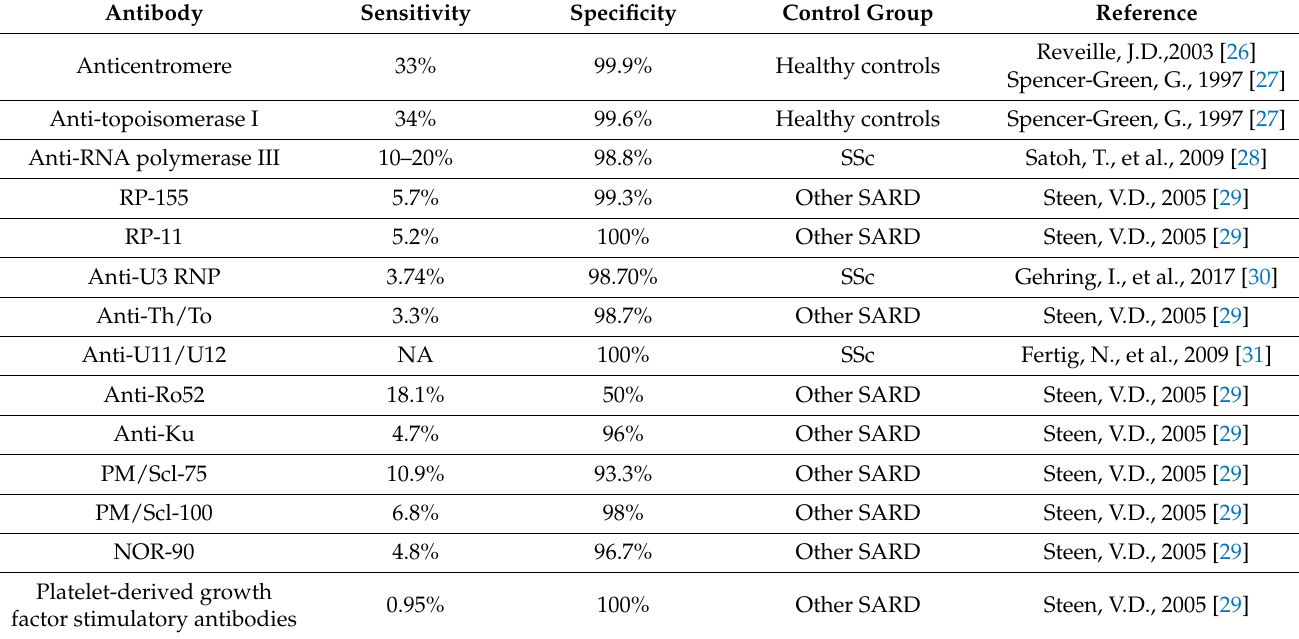
Table 2. Summary of antibody sensitivity and specificity in systemic